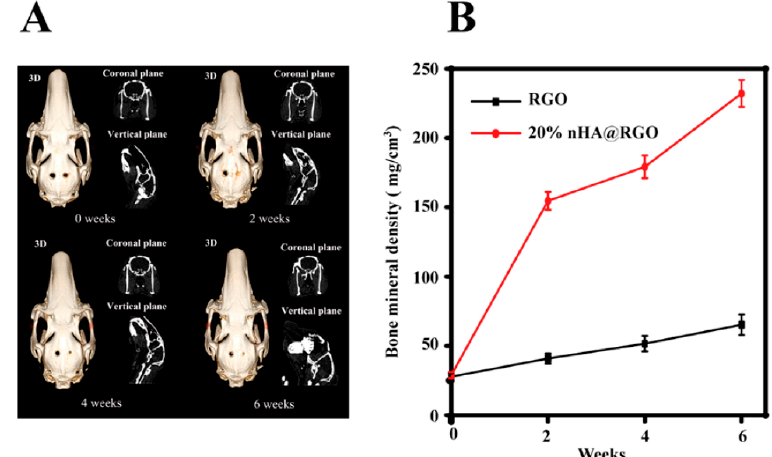
Figure 4. Proliferation and of bone mineral density (BMD) of rat bone mesenchymal cells. ( A ) Computed tomography analysis of the defect repair at different time interval. The left defect planted by free reduced graphene oxide scaffold, and the right treated with 20% nHA@RGO scaffold. ( B ) The change of bone mineral density (BMD) after the scaffold implantation [71] (copyright 2017, Carbon). Materials 2018 , 11 , x FOR PEER REVIEW